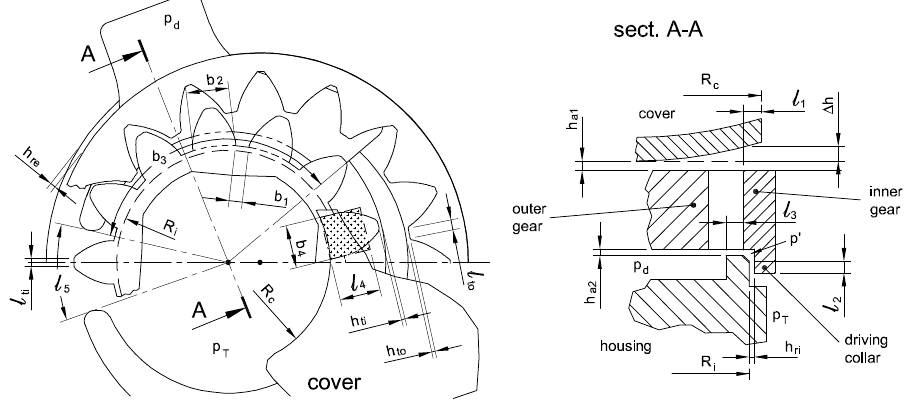
Figure 5. Definition of the geometric parameters for the modelling of the leakages.